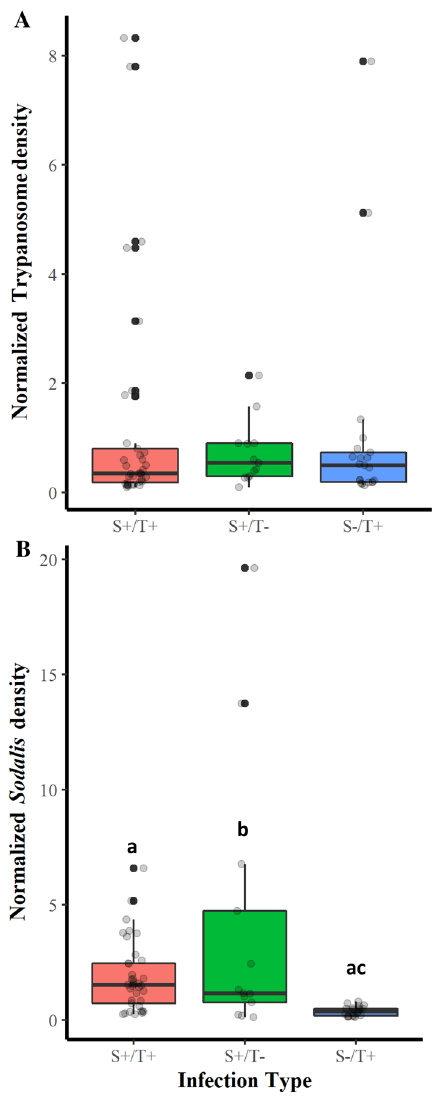
Figure 4. Impact of co-infection with Trypanosoma and Sodalis on Trypanosoma ( A ) and Sodalis ( B ) density in Glossina pallidipes and G. m. morsitans . Bars marked with the same lower-case letter do not differ significantly at the 0.05